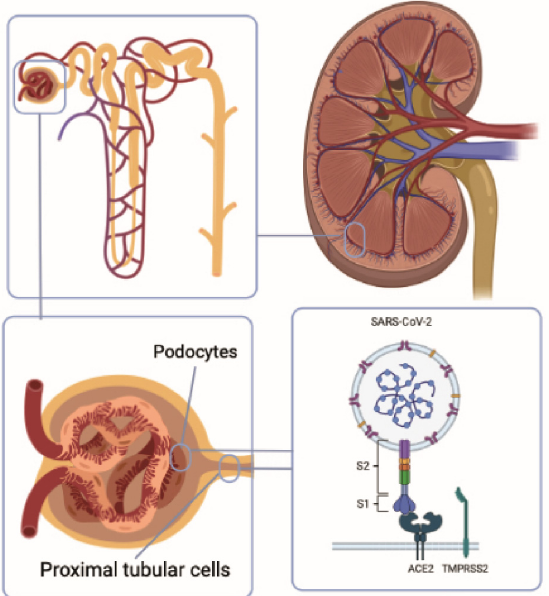
Figure 1. SARS-CoV-2 infects the kidney. The kidney is one of the organs that most expresses ACE2, the receptor that SARS-CoV-2 uses to enter cells. The renal cells with the highest expression are proximal tubular cells and podocytes.